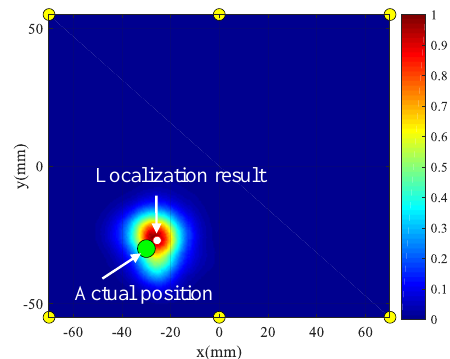
Figure 20. Imaging result of Damage 1.